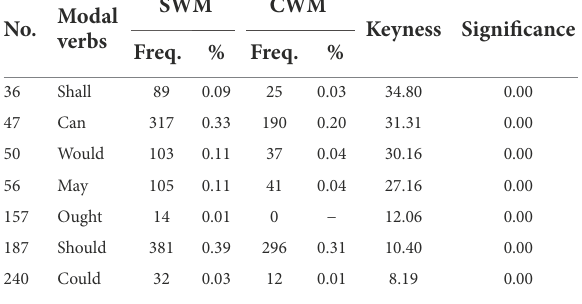
TABLE 14 Key modal verbs in MRP (in comparison with WCH).